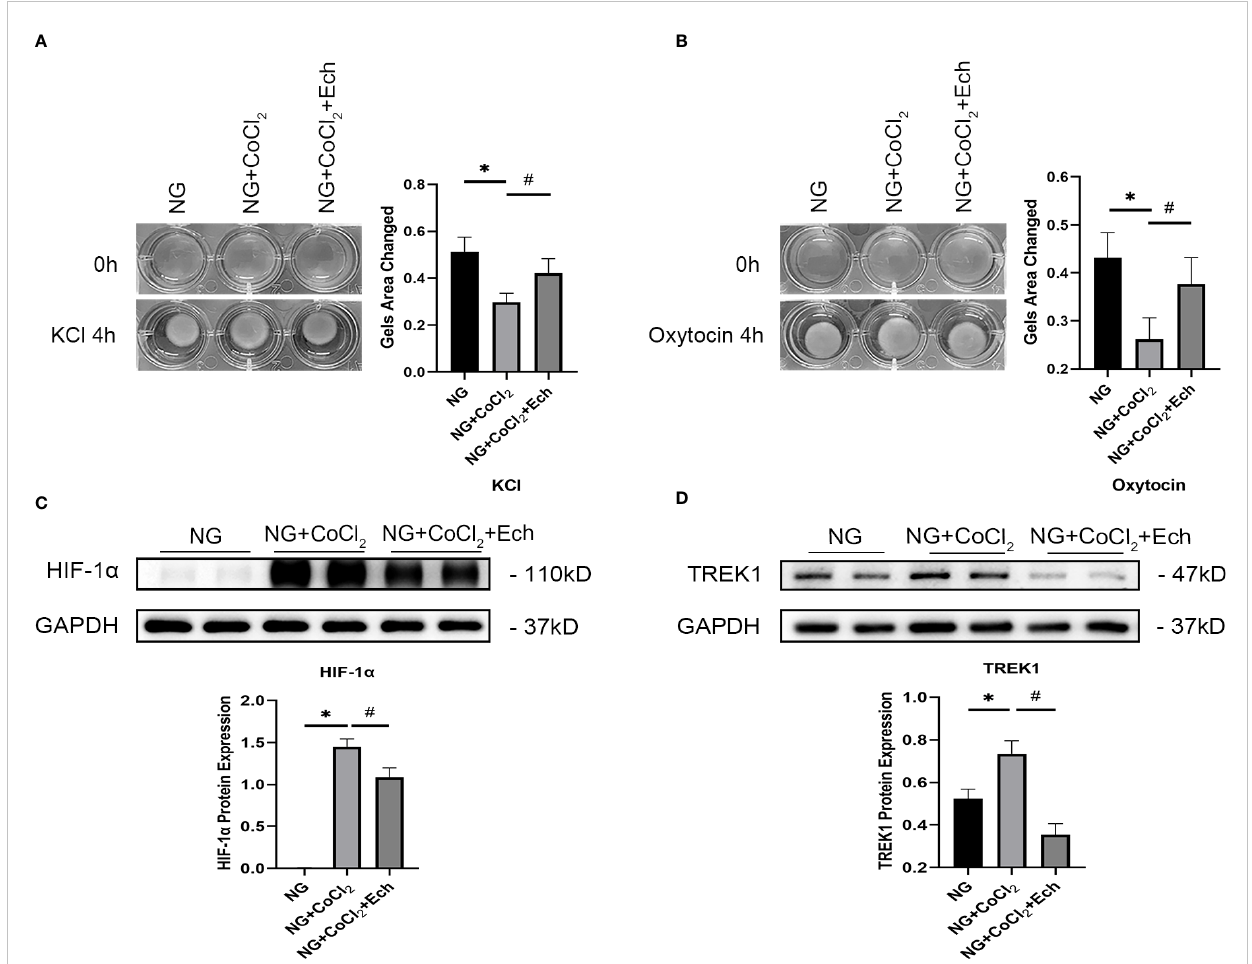
FIGURE 6 Hypoxia inhibition recovered the CoCl 2 -decreased cell contractility in HUSMCs. We divided HUSMCs into the normal glucose (NG, 5.5 mmol/L) group, the normal glucose with CoCl 2 (NG+CoCl 2 ) group, and the normal glucose + CoCl 2 with echinomycin (NG+CoCl 2 +Ech) group in a 24-well culture plate. The medium was added after collagen polymerization (0 h). The images of collagen stimulated by KCl (A) or oxytocin (B) for 4 h. The contraction of HUSMCs was assessed by measuring the mean gel area change. The HUSMCs of each group were cultured in NG medium at the beginning. Then, the NG medium in NG+CoCl 2 and NG+CoCl 2 +Ech groups was replaced with NG+CoCl 2 medium for 24 h when the cell density reached 60% – 70%, after which echinomycin was added to the NG+CoCl 2 +Ech group for 4 h. The total protein of each group was then extracted, and HIF-1 a (C) and TREK1 (D) protein expression was measured by western blot analysis. Data are presented as means ± SEM, n = 4 for each group. * means NG+CoCl 2 vs. NG and P<0.05, # means NG+CoCl 2 +Ech vs. NG+CoCl 2 and P<0.05. HIF-1 a , hypoxia-inducible factor-1 alpha; HUSMCs, human uterine smooth muscle cells; SEM, standard error of the mean; TREK1, TWIK-1-related potassium